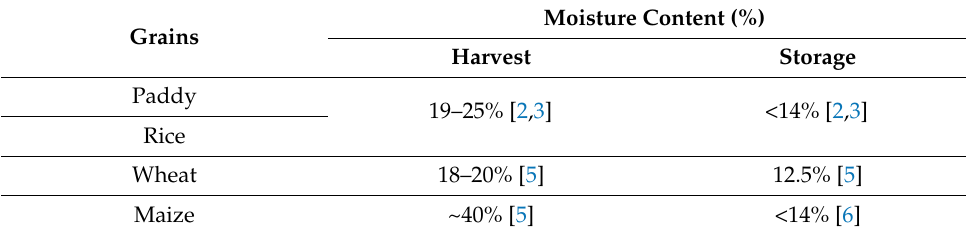
Table 1. Moisture content during harvest and storage for a different type of grains.